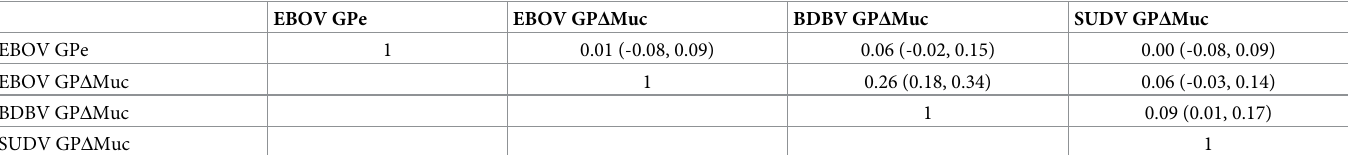
Table 3. Intraclass correlation coefficients (ICCs) and 95% confidence intervals for pairwise concurrence of Ebola virus-specific and ebolavirus cross-reactive anti- body levels among of 539 participants from Mbandaka and the surrounding areas in the Democratic Republic of the Congo, August